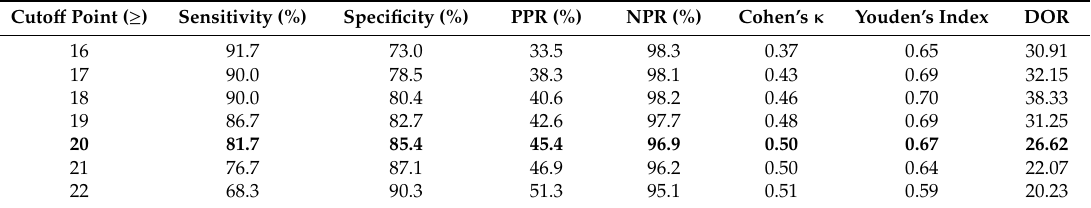
Table 3. Cuto ff point of the C-IGDC based on the Diagnostic and Statistical Manual of Mental Disorders (DSM-5)-proposed diagnostic criteria of Internet gaming disorders (IGD) ( N = 464). Cuto ff Point ( ≥ ) Sensitivity (%) Specificity (%) PPR